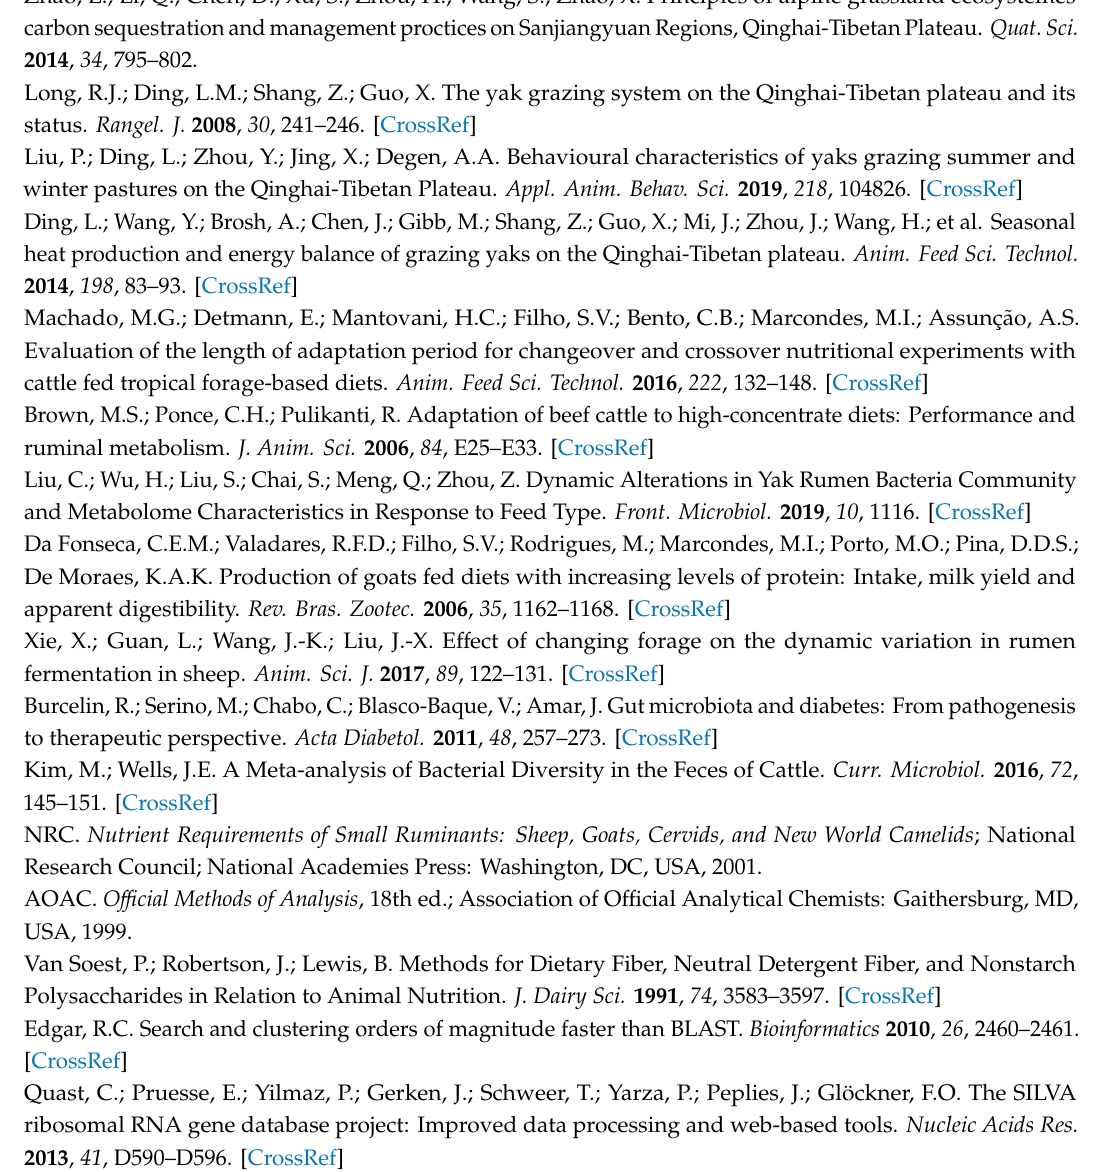
Table S1: Statistical table of post-filtering sequencing